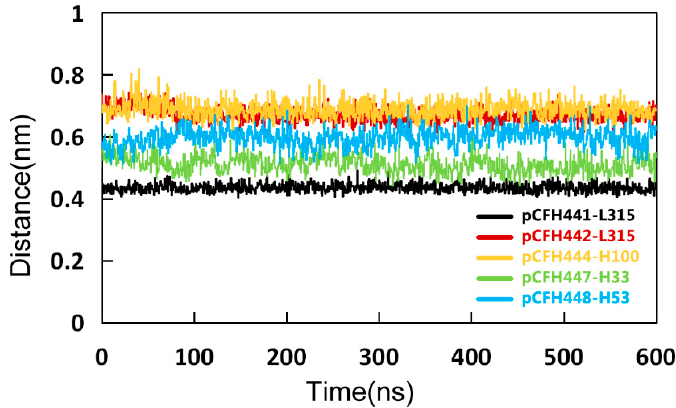
Figure 6. The Key amino acid distances between pCFH and Ab42. The distances of pCFH441-L315, pCFH442-L315, pCFH444-H100, pCFH447-H33, and pCFH448-H53 were represented by black, red, yellow, green, and blue curves, respectively.